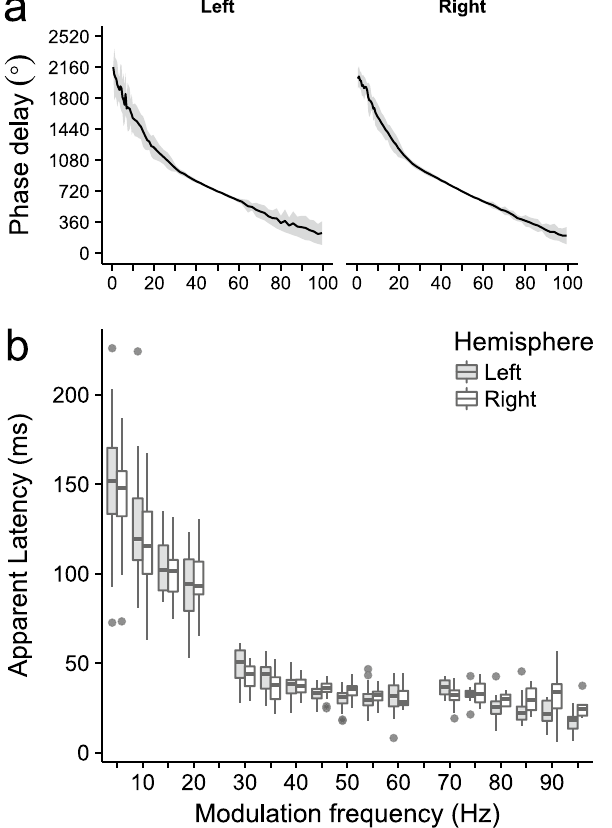
Figure 9. Phase delay and apparent latency. ( a ) Group average phase delays ± one standard deviation as a function of modulation frequency for the left and right hemispheric channel . The phase delay at 50 Hz of each individual was set to 720° for illustrative purposes, note that this affects the presented standard deviations. ( b ) the apparent latencies as a function of modulation frequency. It is clear from ( b ) that with the increase of modulation frequency the predominate generators of the ASSR shift downwards in the ascending auditory